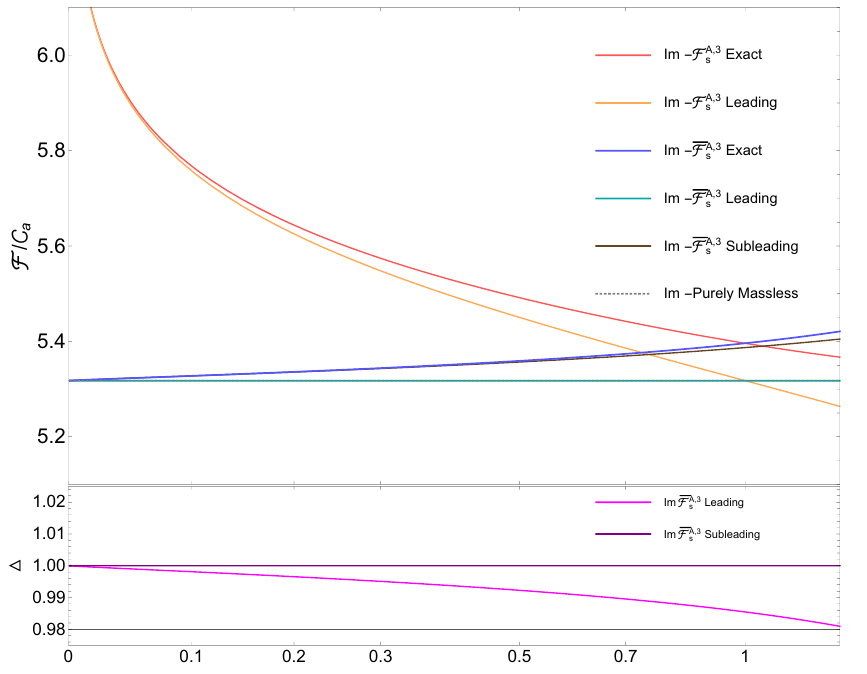
Figure 6 . Comparison of the imaginary part of the exact result for ¯ F A, 3 subleading large-mass approximation, as function of x = s/m 2 similar way as in figure